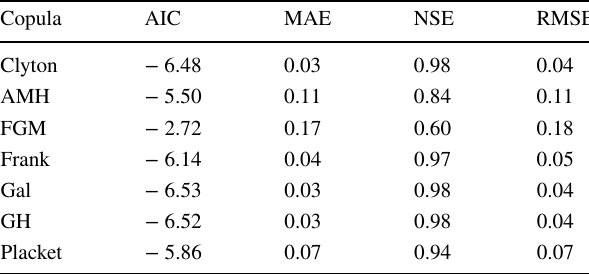
Table 4 Results of fitting different copula functions on pair-variables of groundwater drawdown variables given by pumping with a con- stant discharge of 26.64 and 28.8 L per second